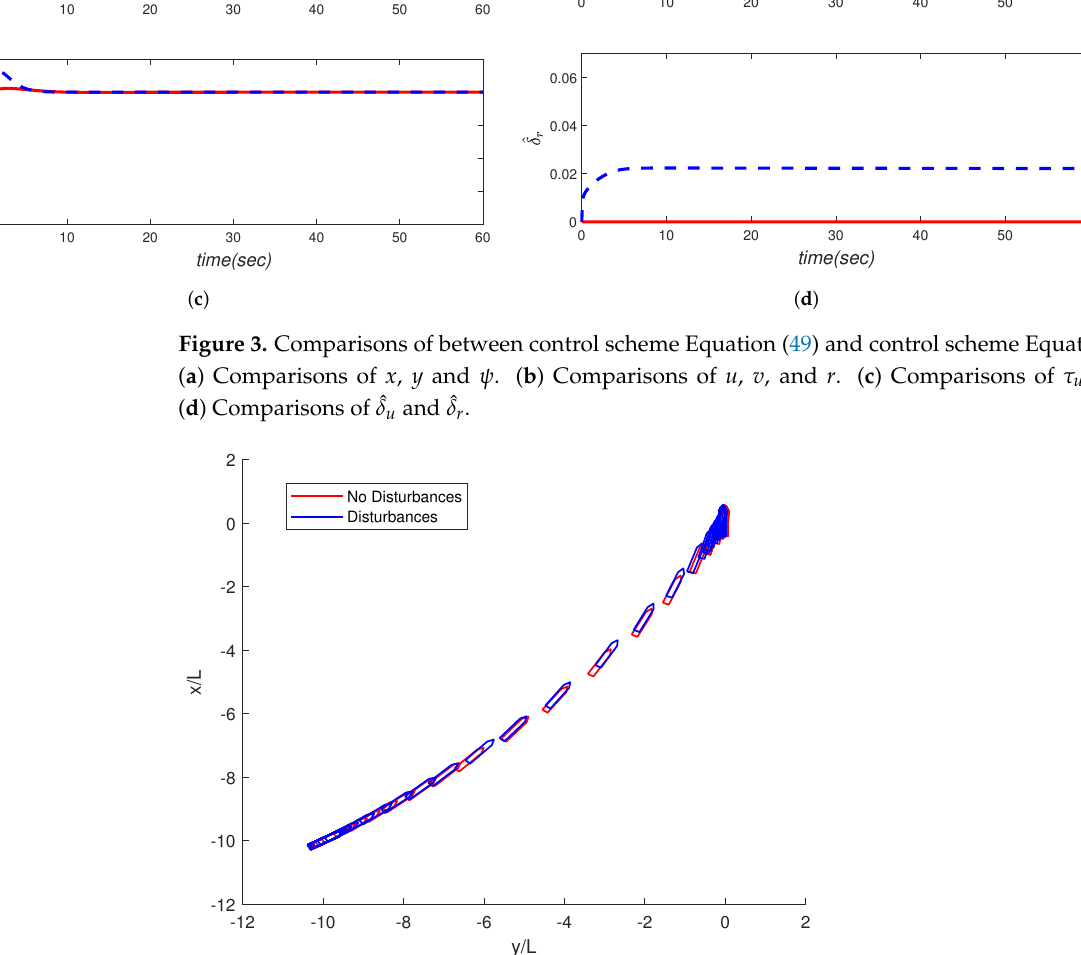
Figure 4. Berthing path comparisons of control scheme Equation (49) under interference and no